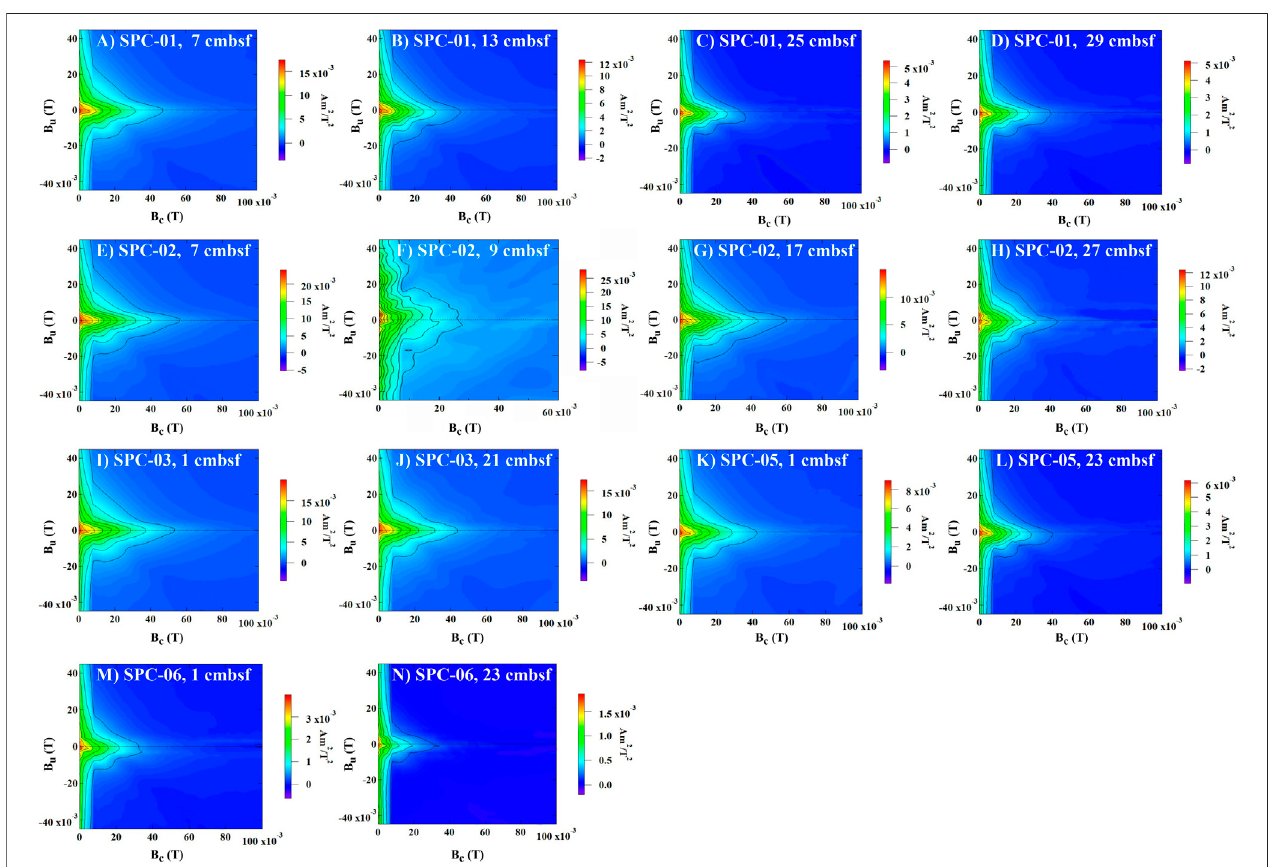
FIGURE 4 | First-order reversal curve diagrams for selected representative samples from spade cores. (A – D) : SPC-01, (E – H) : SPC-02, (I – J) : SPC-03, (K – L) : SPC-05, and (M – N) : SPC-06.